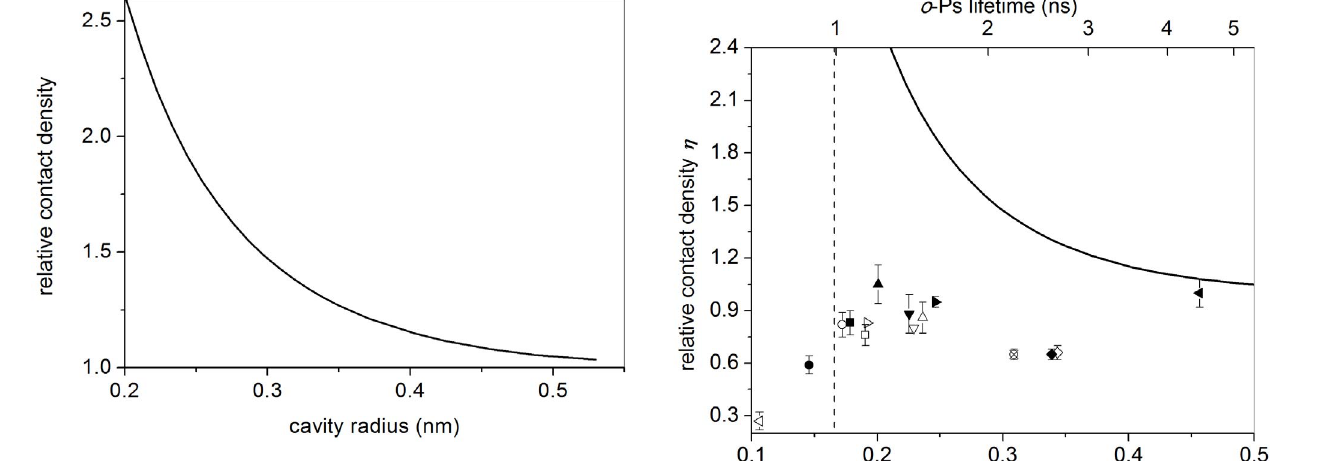
Figure 2. Relative contact density versus the cavity radius r 0 ; only confinement effects are considered.